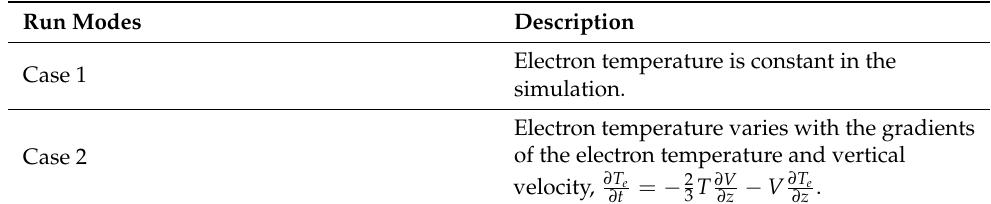
Table 2. Run modes of the simulation with different parameters.